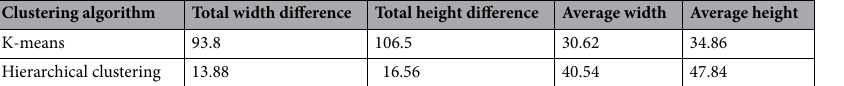
Table 6. Experimental results of K-means and hierarchical clustering.